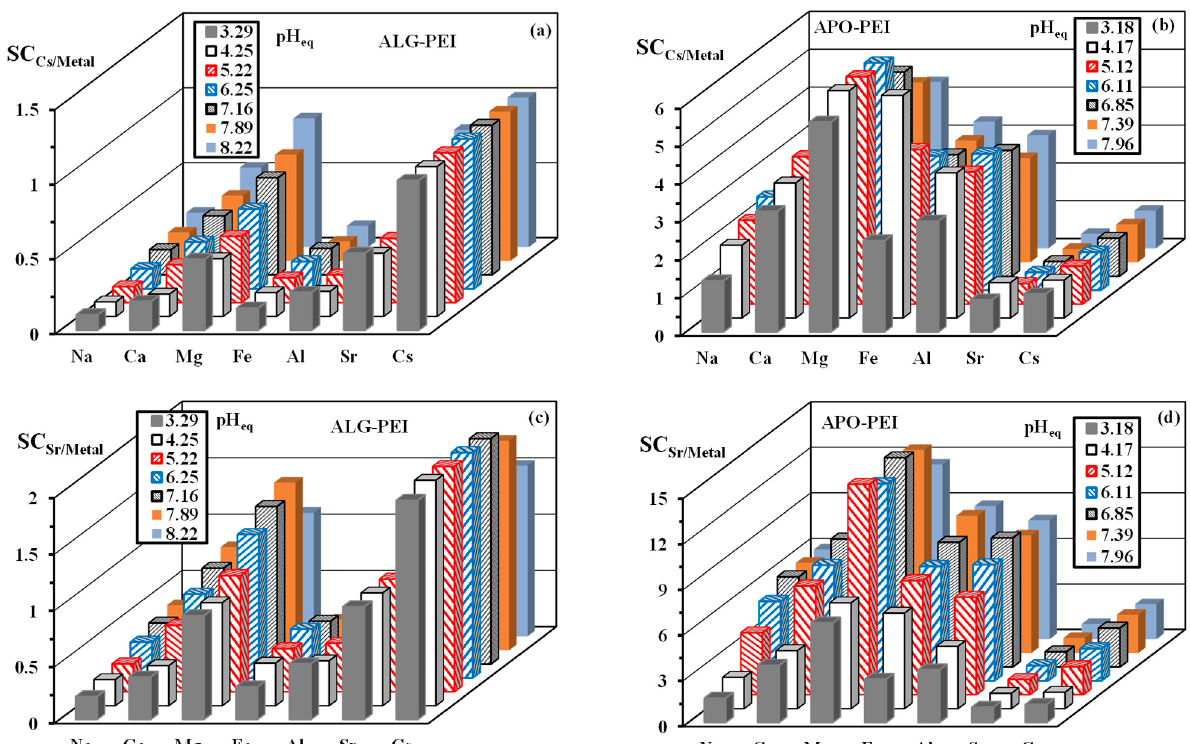
Figure 5. Metal sorption from multicomponent solutions using ALG-PEI ( a , c ) and APO-PEI ( b , d ) sorbents: effect of pH eq on SC Cs/metal ( a , c ) and SC Sr/metal ( b , d ) (C 0 , mmol L − 1 : 0.883 Na(I), 0.530 Ca(II), 1.020 Mg(II), 0.881 Fe(III), 0.875 Al(III), 1.088 Cs(I), and 0.959 Sr(II); time: 24 h; v: 210 rpm; T: 21 ± 1 °C; SC Cs/Cs and SC Sr/Sr are mentioned as internal standard = 1).